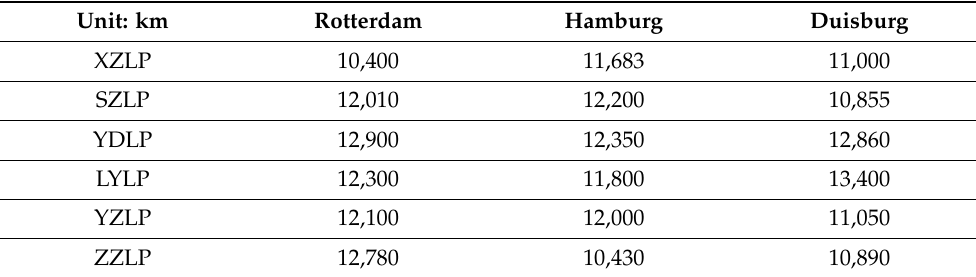
Table A4. Transport distance from inland ports to foreign hubs by CRE. Unit: